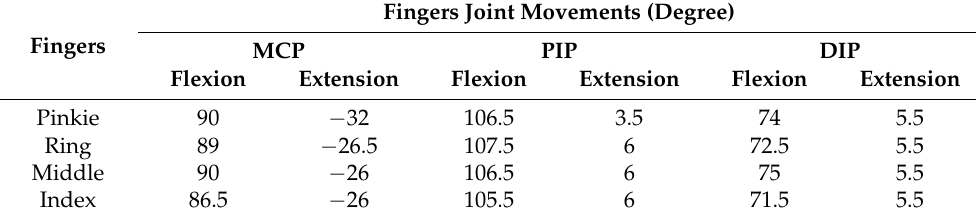
Figure 1. Fingers movements of flexion and extension. Table 1. Fingers joints movements of flexion and extension.